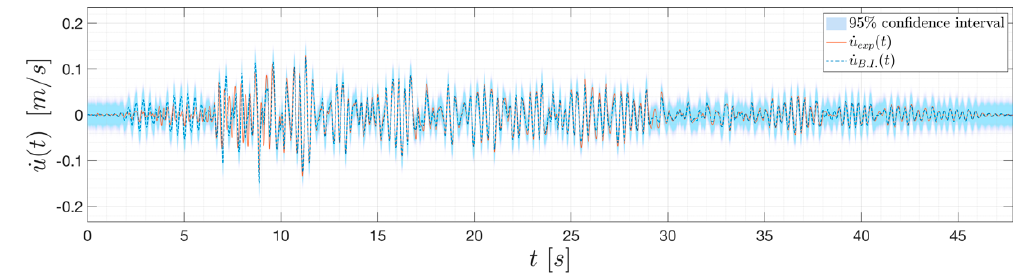
Figure 6. Velocity response prediction of the BWBN benchmark model.